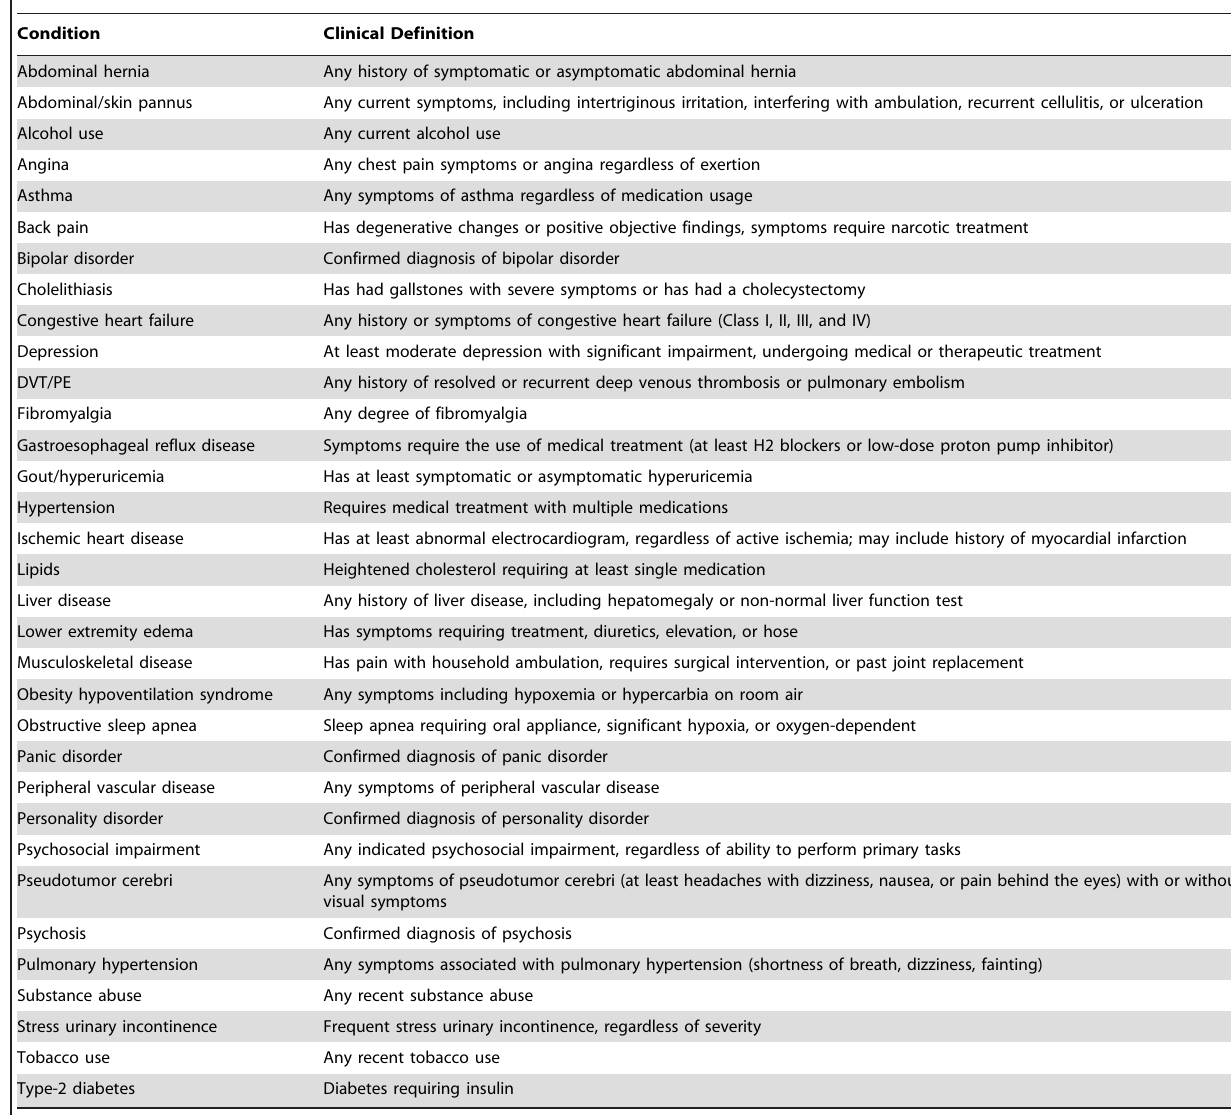
Table 1. Clinical definitions of pre-existing